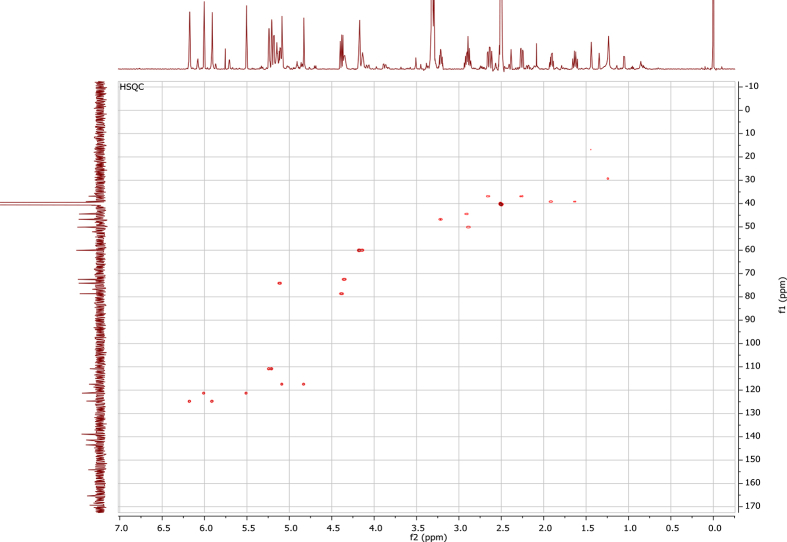
HSQC (DMSO-d6) spectrum of compound 12.